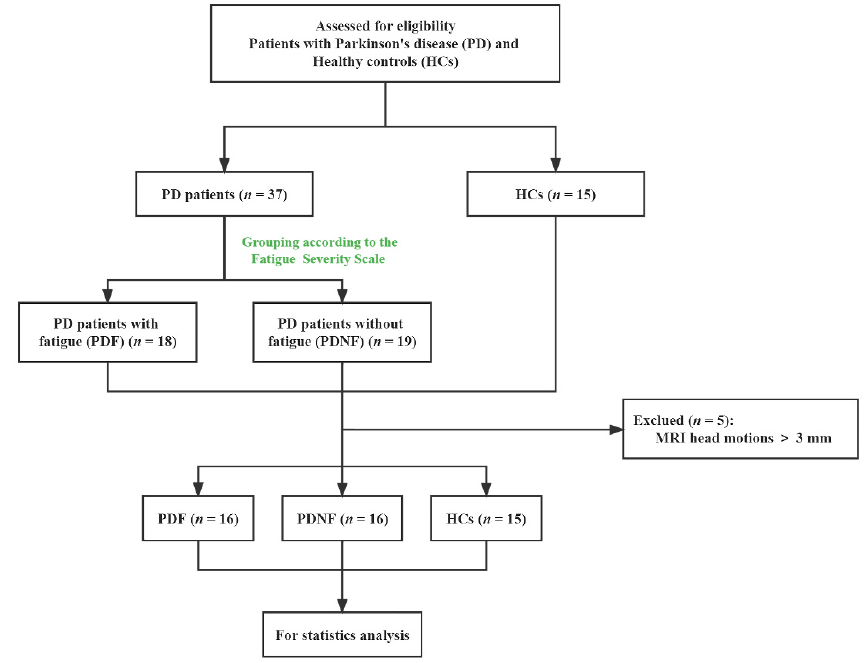
Figure 1. Study flow diagram. MRI: magnetic resonance imaging.